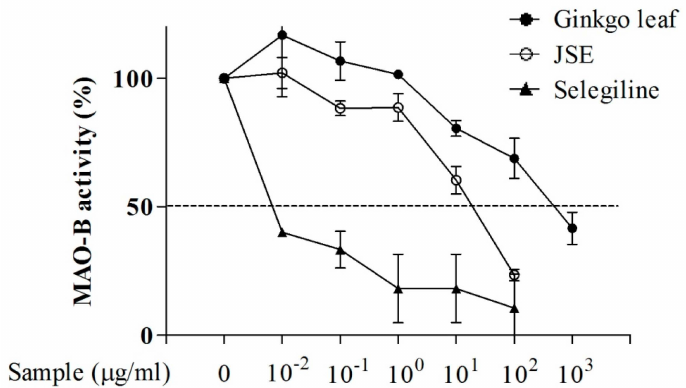
Figure 2. Inhibitory effect of JSE on MAO-B activity in vitro . JSE and positive controls (Ginkgo leaf extract and selegiline) inhibited Monoamine Oxidase B (MAO-B) activity in a concentration-dependent manner from 0, 0.01, 0.1, 1, 10, 100 µ g/mL.